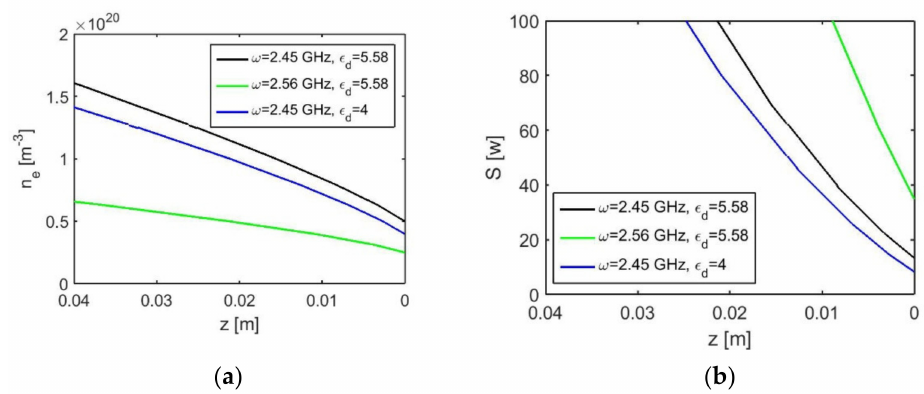
Figure 4. Theoretical axial distribution for the discharge tube 8 mm/2 mm at different discharge conditions of ( a ) plasma density; ( b ) wave power.